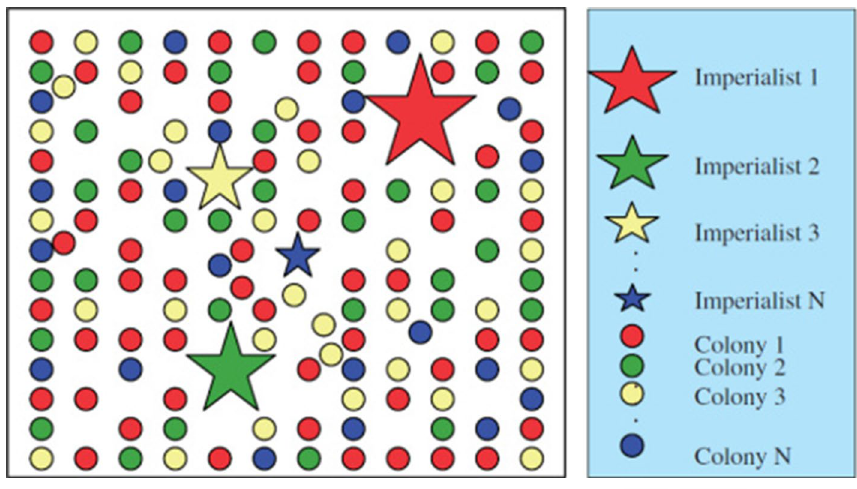
Fig. 3 Generating the initial empires: how an imperialist possesses more colonies, the relevant ★ mark will be bigger (Khalili et al. 2016)